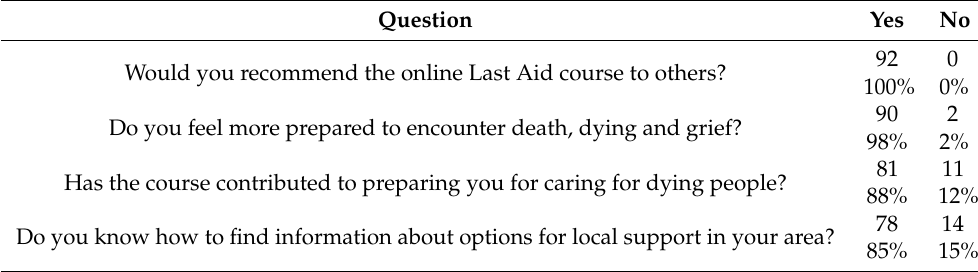
Table 3. Answers about effects of the online Last Aid course